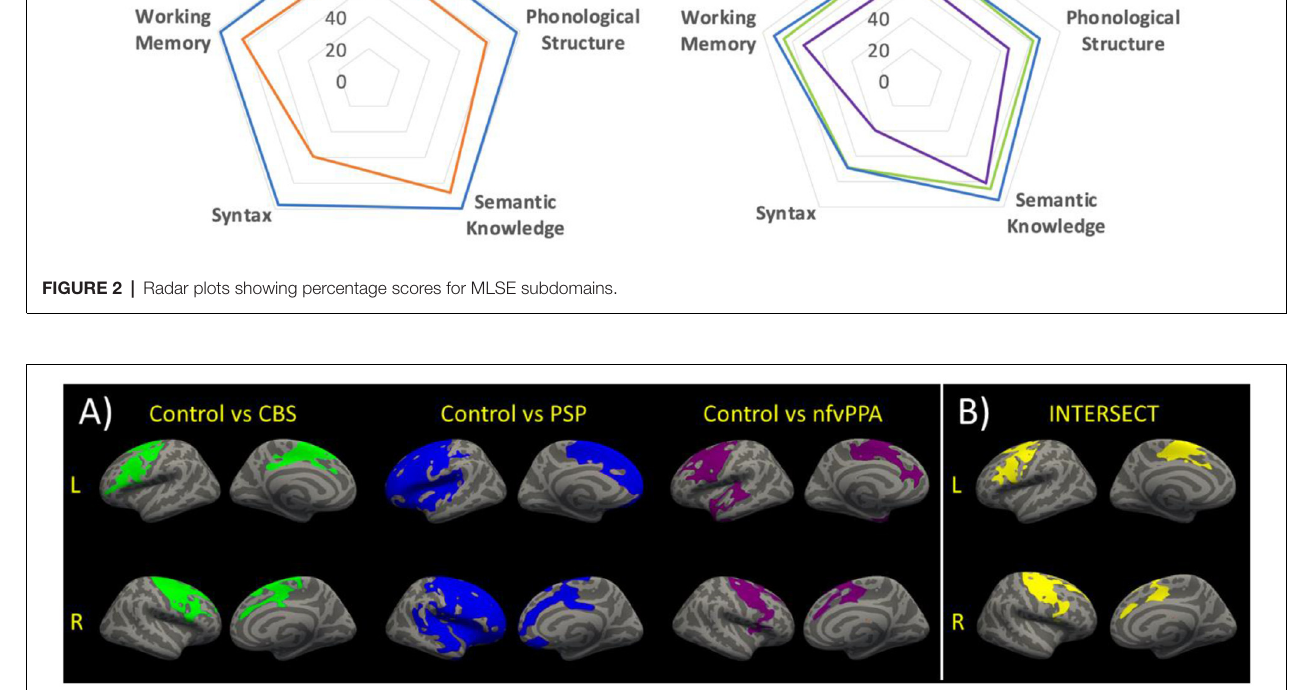
FIGURE 3 | (A) Reduced cortical thickness in each patient group vs. the control group. Clusters show regions of significant reductions in cortical thickness between each patient group and the controls following clusterwise correction at p < 0.05. (B) For visualisation purposes, the intersect of the clusters for the three group comparisons of cortical thickness is shown. The intersect shows overlapping regions of reduced cortical thickness in the three patients vs. controls comparisons.